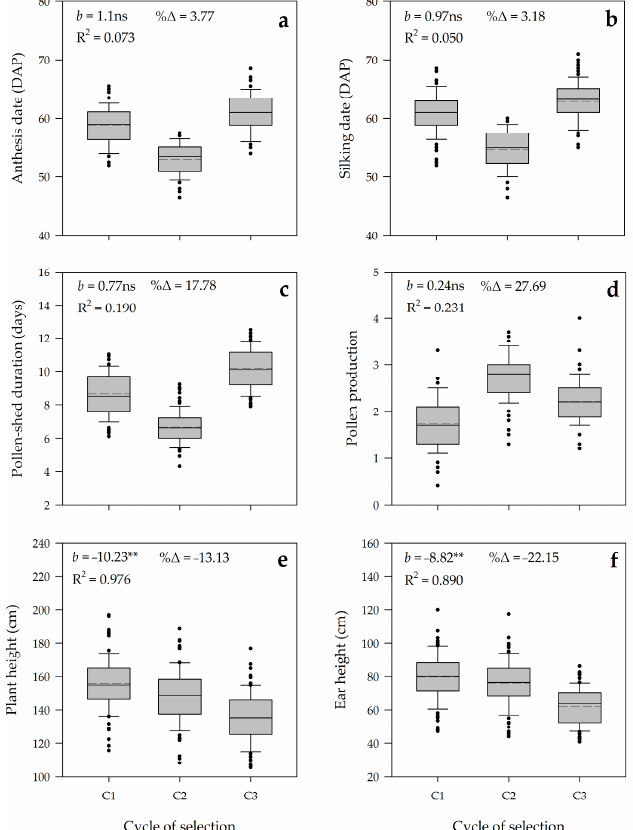
Figure 7. Parallel boxplots of 78 families of putative tropical haploid inducer for agronomic traits as an indirect response to three cycles of selection. ( a ) Anthesis date (DAP); ( b ) Silking date (DAP); ( c ) Pollen-shed duration (days); ( d ) Pollen production; ( e ) Plant height (cm); and ( f ) Ear height (cm). b realized genetic gain per cycle. R 2 coefficient of determination. % Δ is percentage increase due to selection. ** b value is significantly different from zero at ≥ 2SE. ns b value is not significantly differ- ent from zero at ≥ SE.